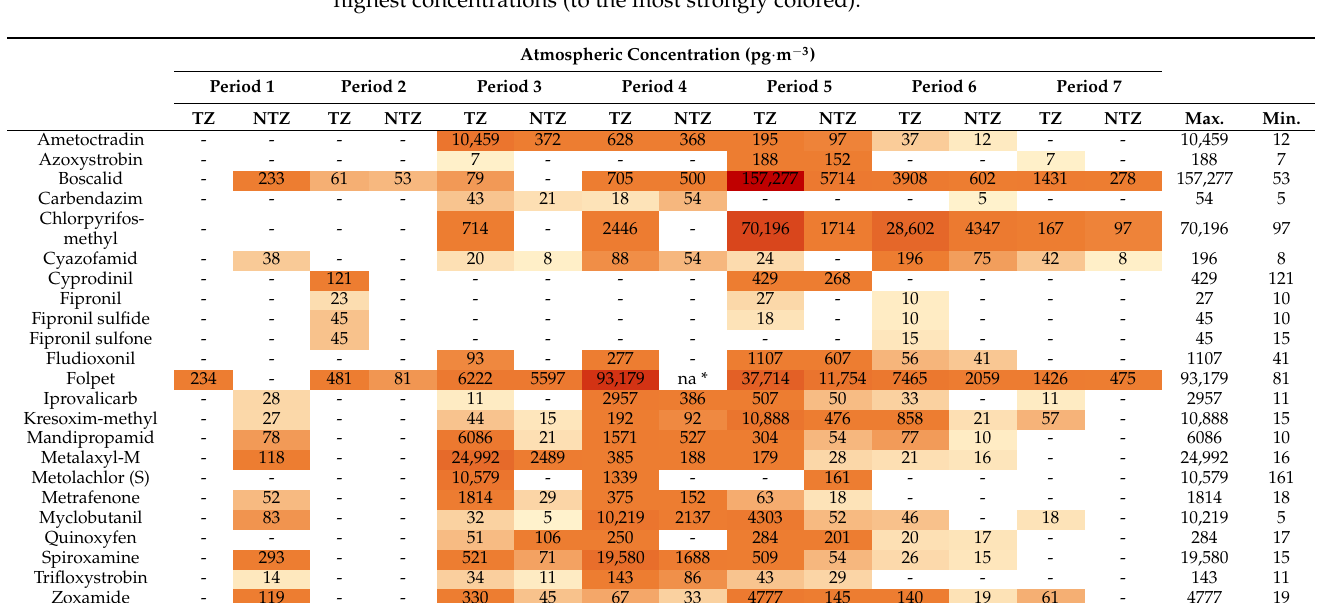
Table 4. Air concentrations (pg m − 3 ) estimated from the cumulative quantities in the PUF-PAS and Rs with correspondence periods (period 1: 20 February–21 March, period 2: 21 March–23 April, period 3: period 7: 11 September–17 October); * na: not analyzed; colors: distribution of air pesticides in 2013 in the treated (TZ) and nontreated (NTZ) zones with the lowest (from the most faintly colored) to the highest concentrations (to the most strongly